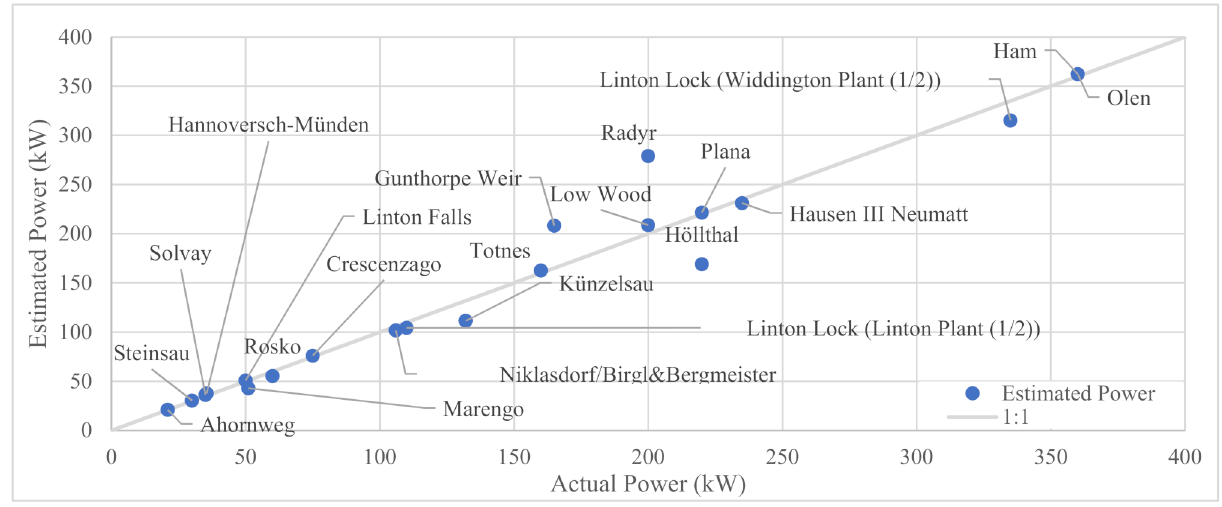
Figure 5. Comparison of the estimated power of each screw vs. the power of each installed screws in ASG hy- dropower